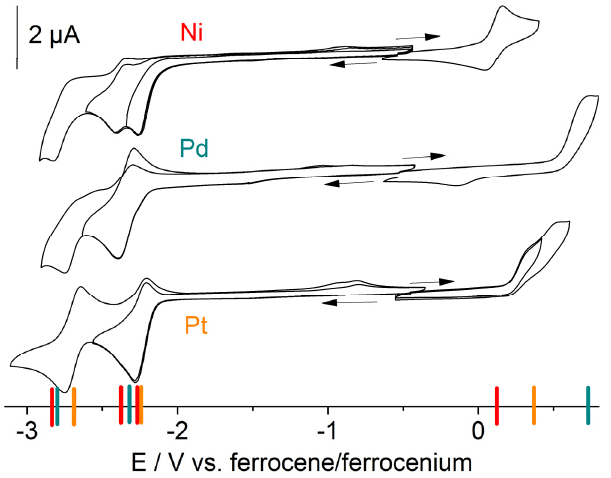
Figure 2. Cyclic voltammograms of [M(Me 2 dpb)Cl] in n- Bu 4 NPF 6 /THF. Coloured bars represent half-wave potentials ( E 1/2 ) for reversible reductions and anodic peak potentials ( E pa ) for irreversible oxidations.